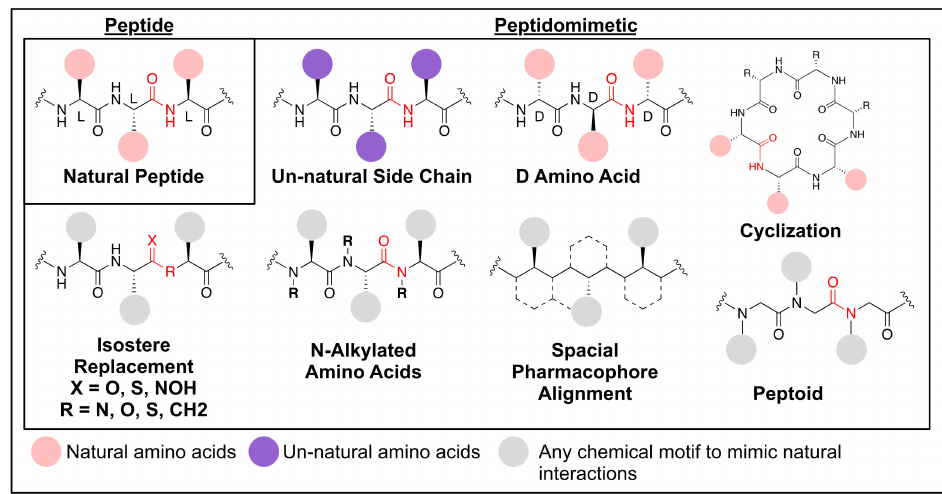
Figure 6. Various synthetic strategies of peptidomimetic. Various peptidomimetics are derived from natural peptide by replacing with un-natural amino acid, or modifying backbone structures to mimic natural peptide